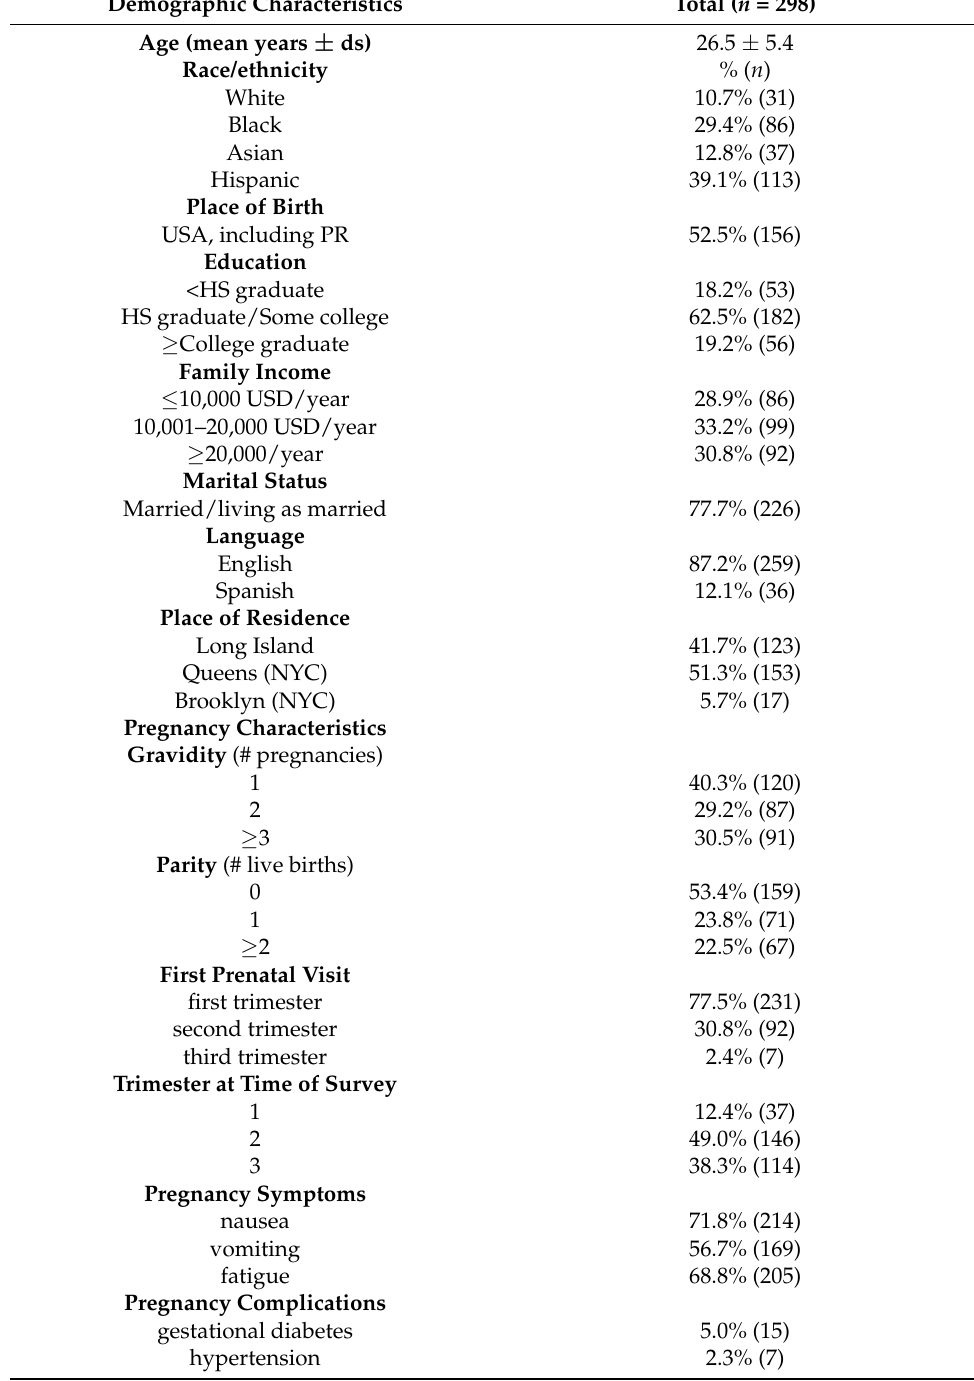
Table 1. Demographic and pregnancy characteristics of the study